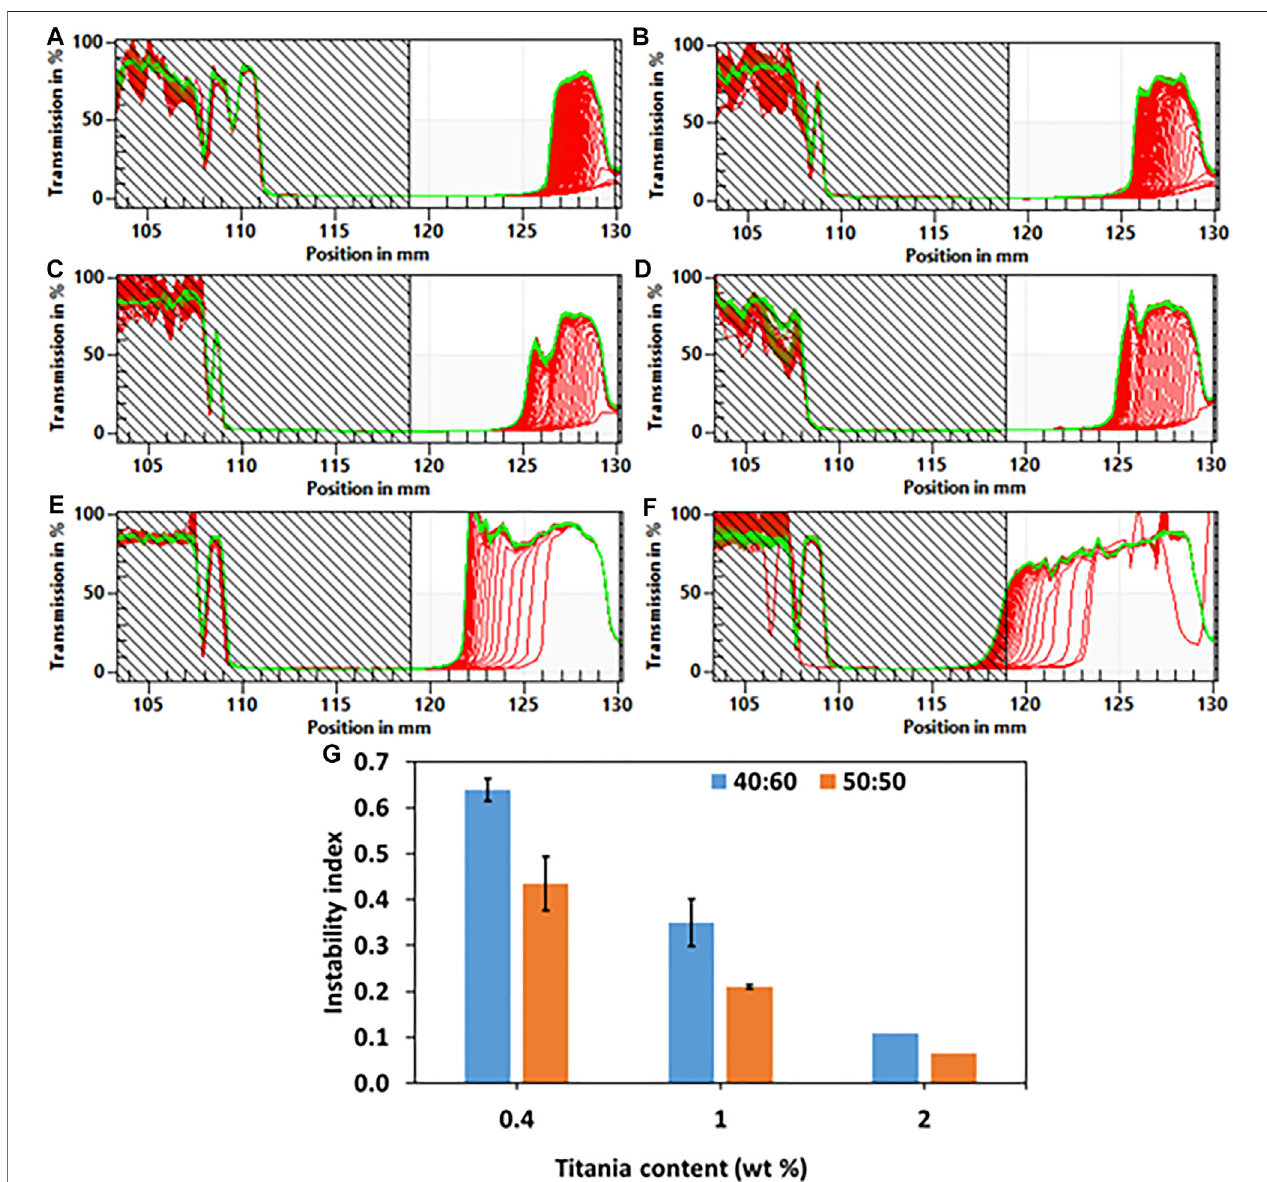
FIGURE 3 | Light transmission curves of Pickering emulsions with 2, 1, and 0.4wt% titania-NH 2 at different oil/water ratios. (A) 40:60, 2wt%. (B) 50:50, 2wt%. (C) 40:60, 1wt%. (D) 50:50, 1wt%. (E) 40:60, 0.4wt%. (F) 50:50, 0.4wt%. (G) The instability index of Pickering emulsions as a function of titania-NH 2 content (wt%) and oil percentagesintheemulsion(vol%).In2wt%titania-NH 2 basedemulsionhavelowerstandarddeviation.Greenlinesrepresentthelatestmeasuredintensitypro fi leswhile red lines represent initial pro fi